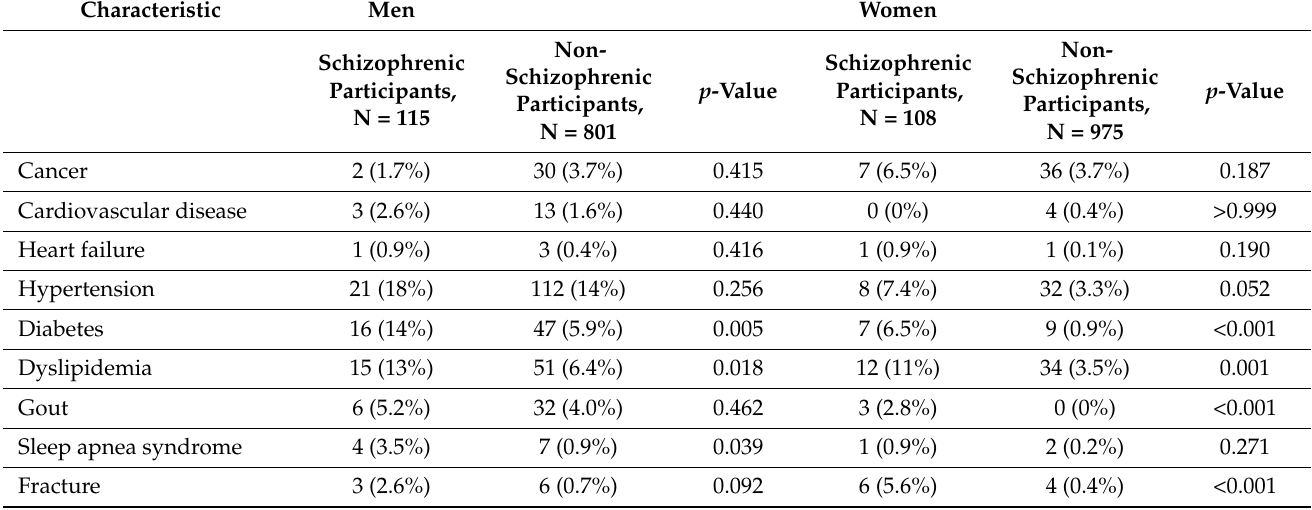
Table 2. Physical comorbidities of participants with schizophrenia and participants without schizophrenia according to